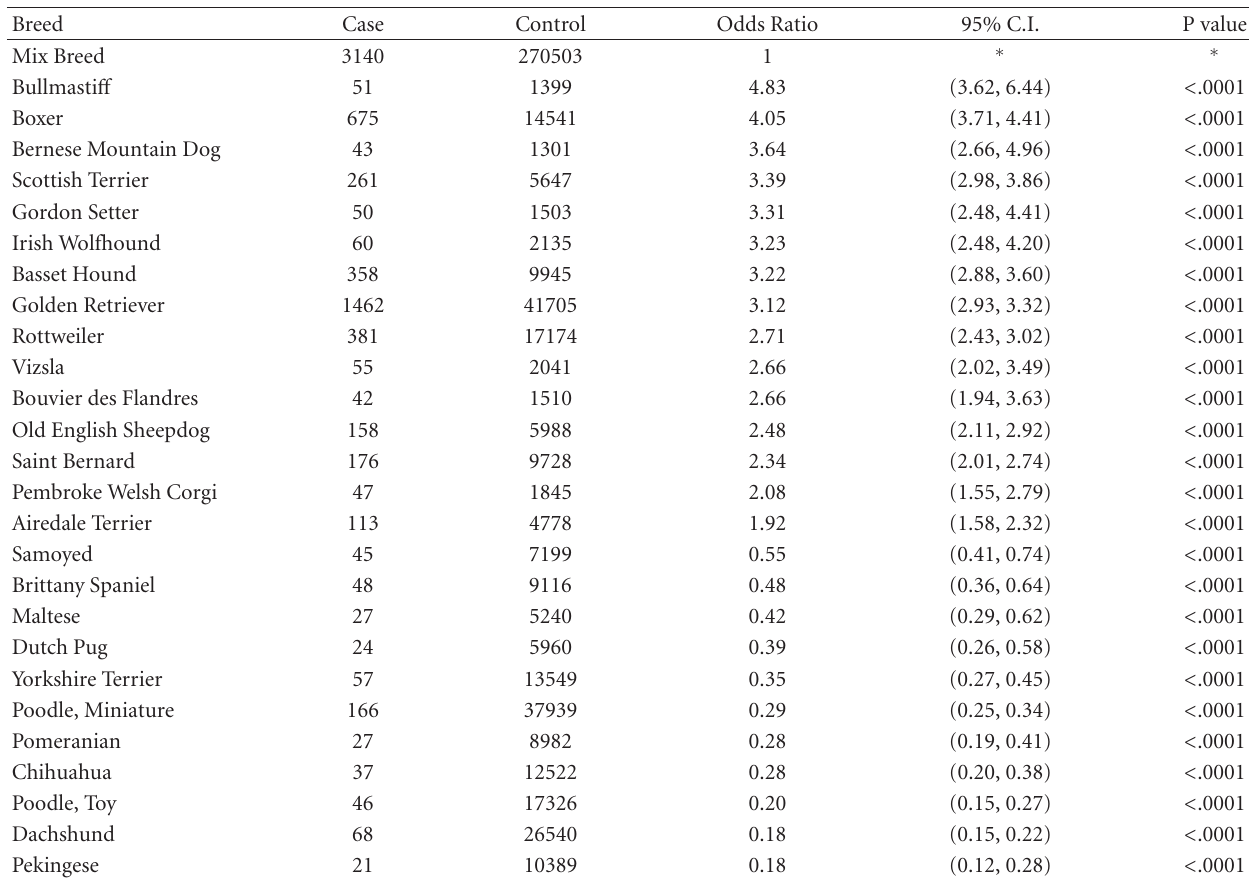
Table 4: Logistic regression model defining the risk of a diagnosis of lymphoma in dogs in the VMDB (1964–2002) as a function of